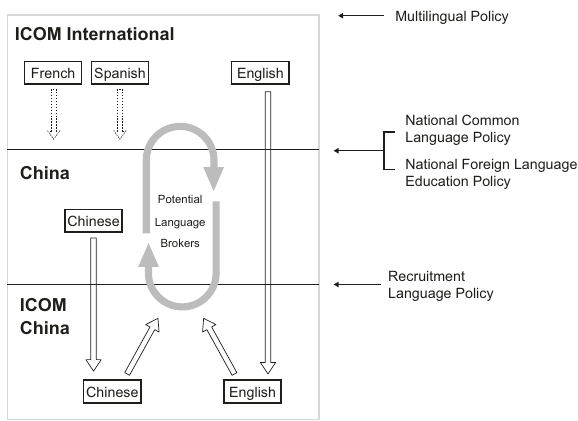
Fig. 1 Language policy layers and the emergence of language